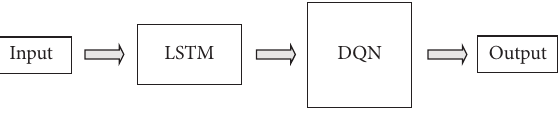
Figure 4: The structure of